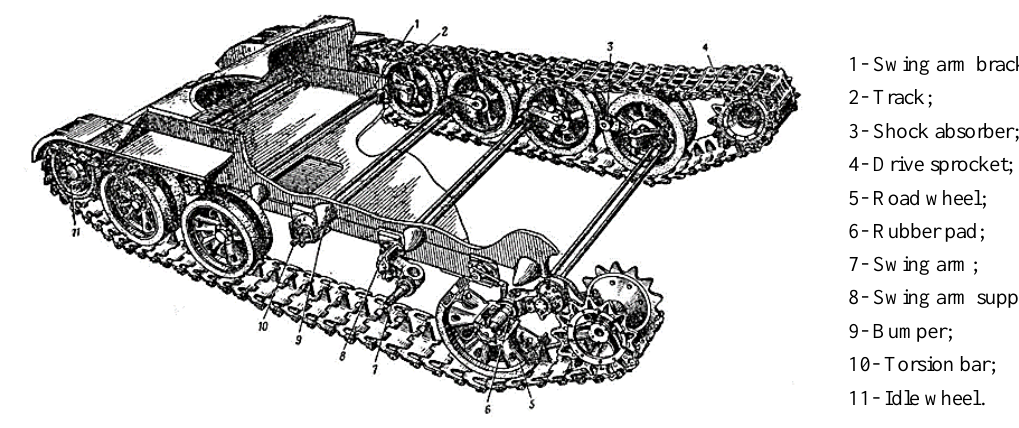
Figure 2. Track vehicle running gear [10].